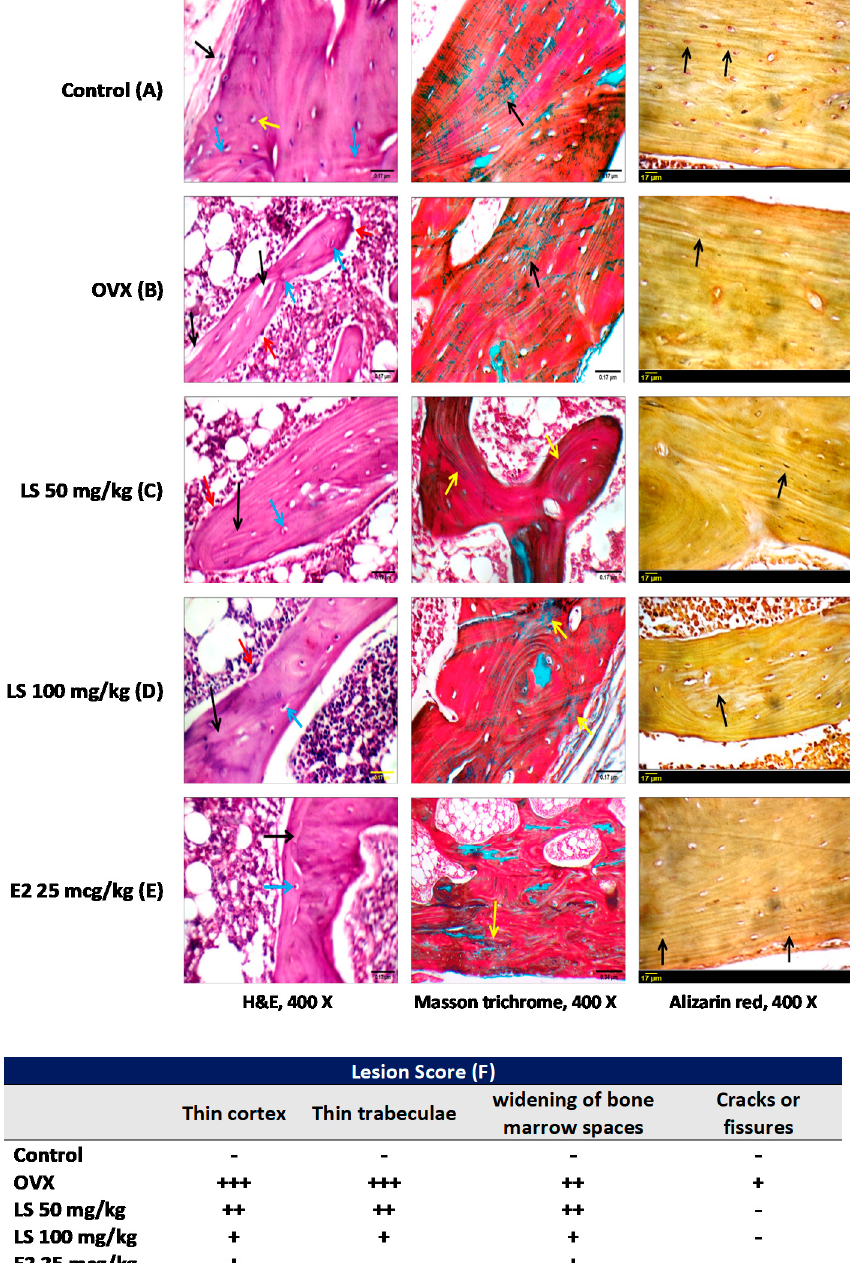
Figure 2. Effect of L. sativum on OVX-induced bone matrix and histological alterations using hematoxylin and eosin (H&E), Masson trichrome, and alizarin red stains. ( A ) Control group showing average periosteum (black arrow), average cortex with regular dense lamellae (blue arrows), small osteocytes (yellow arrow) (H&E), cortex with parallel regular collagen fibers (black arrow) (Masson trichrome), cortex reactive for alizarin red with regular lamellae with parallel small osteocytes (black arrow) (alizarin red). ( B ) Ovariectomized untreated animals showing thin eroded bony trabeculae (black arrow) with large osteocytes (blue arrow) and osteoblastic rimming (red arrow) (H&E), irregular arrangement of collagen fibers in cortex (black arrow) (Masson trichrome), non-reactive cortex for alizarin red showing irregular lamellae (black arrow) (alizarin red). ( C ) Ovariectomized rats treated with 50 mg/kg L. sativum extract demonstrating bony trabeculae with irregular dense lamellae (black arrow), large osteocytes in large lacunae (blue arrow), and osteoblastic rimming (red arrow) (H&E), regular arrangement of collagen fibers in trabeculae (yellow arrow) (Masson trichrome) and cortex less-reactive for stain (black arrow) (alizarin red). ( D ) Ovariectomized rats treated with 100 mg/kg L. sativ um extract illustrating bony trabeculae (black arrow), large osteocytes in large